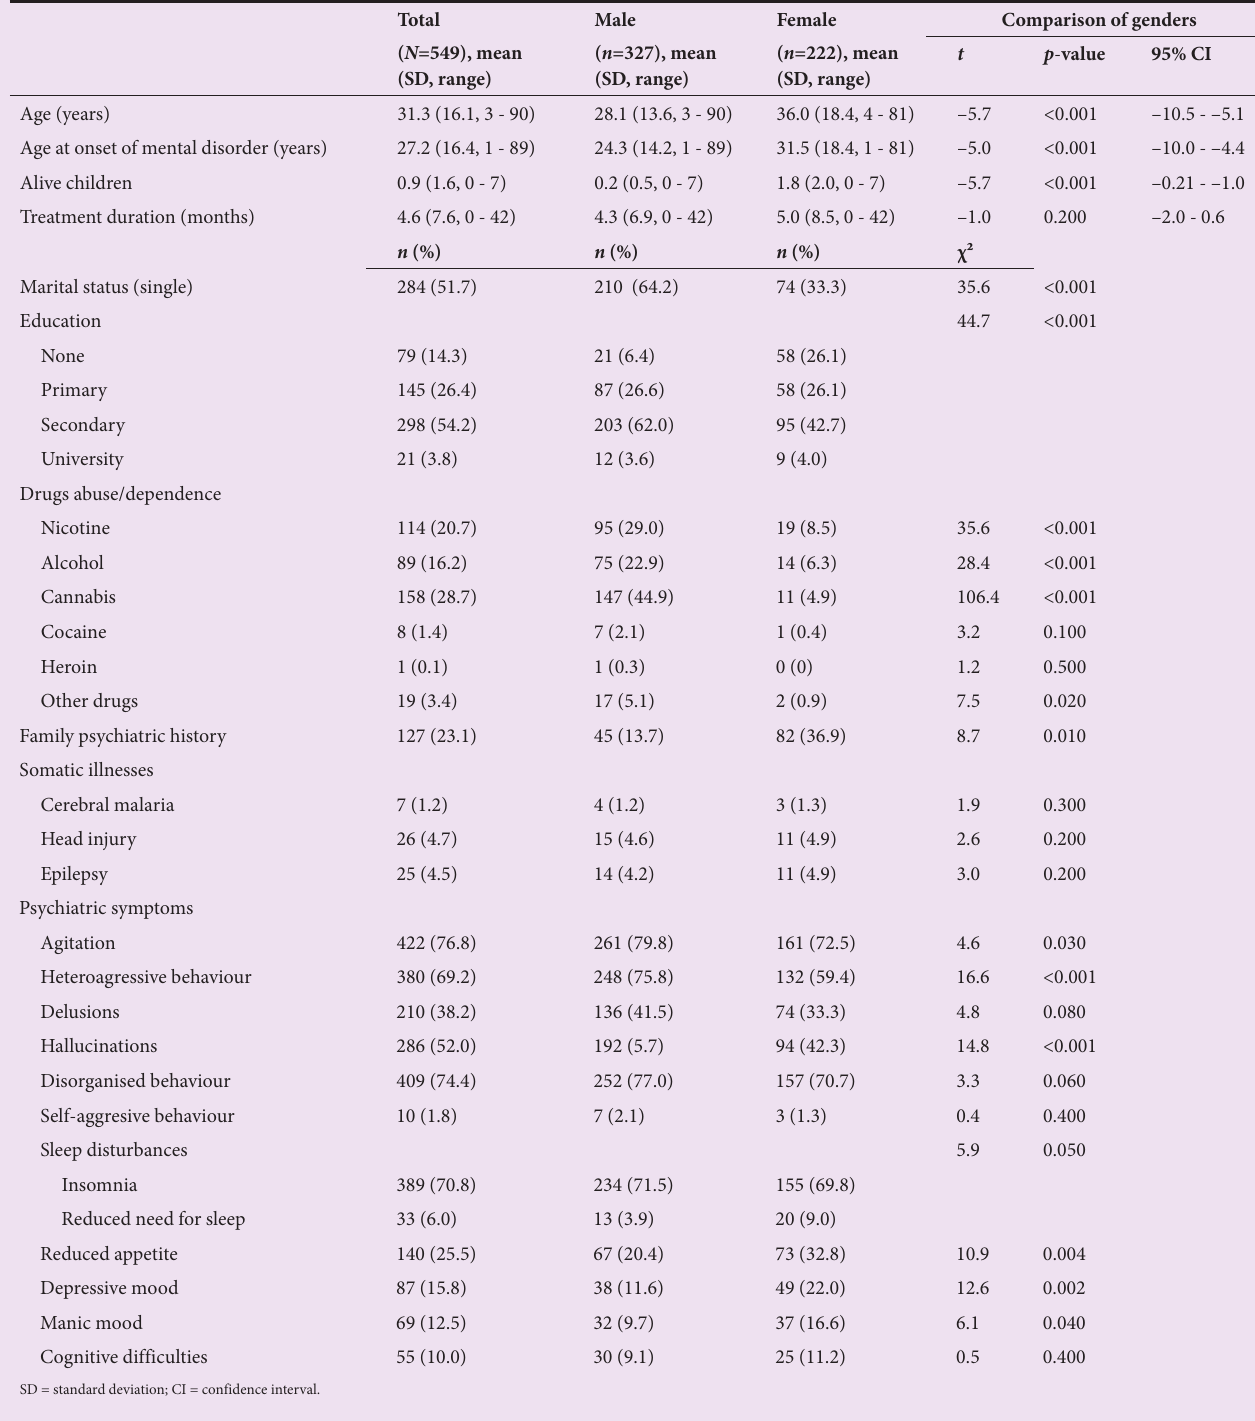
Table 1. Sociodemographic and clinical data of the patients assessed in the mental health